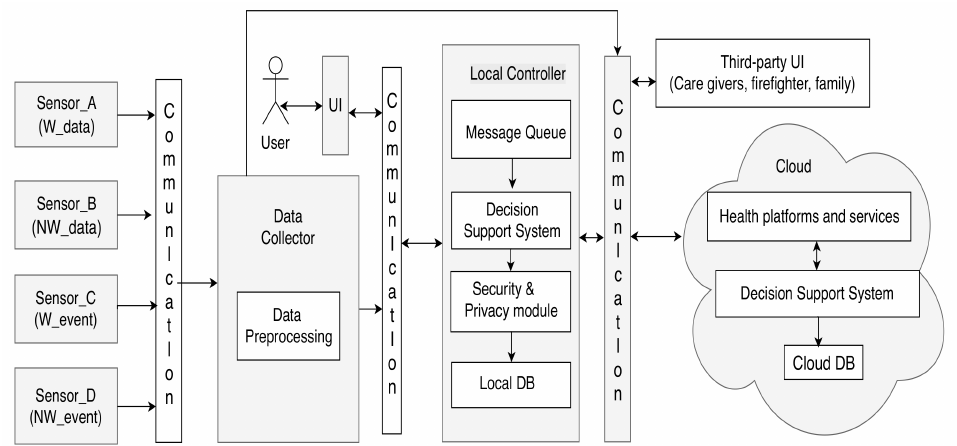
Figure 1. Architecture of an AALS described in